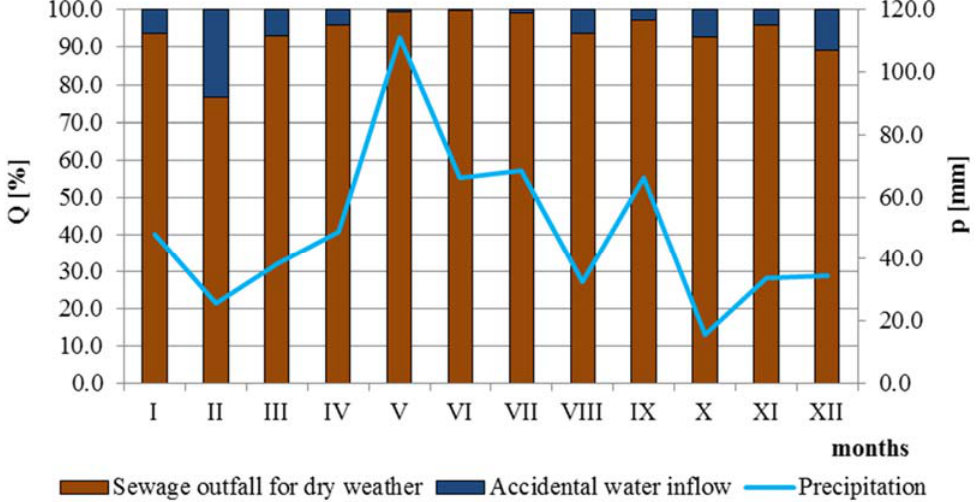
Figure 3. The average percentage of incidental water flowing into the sewage system of the urban agglomeration of Radom against the background of the average monthly amount of atmospheric precipitation.